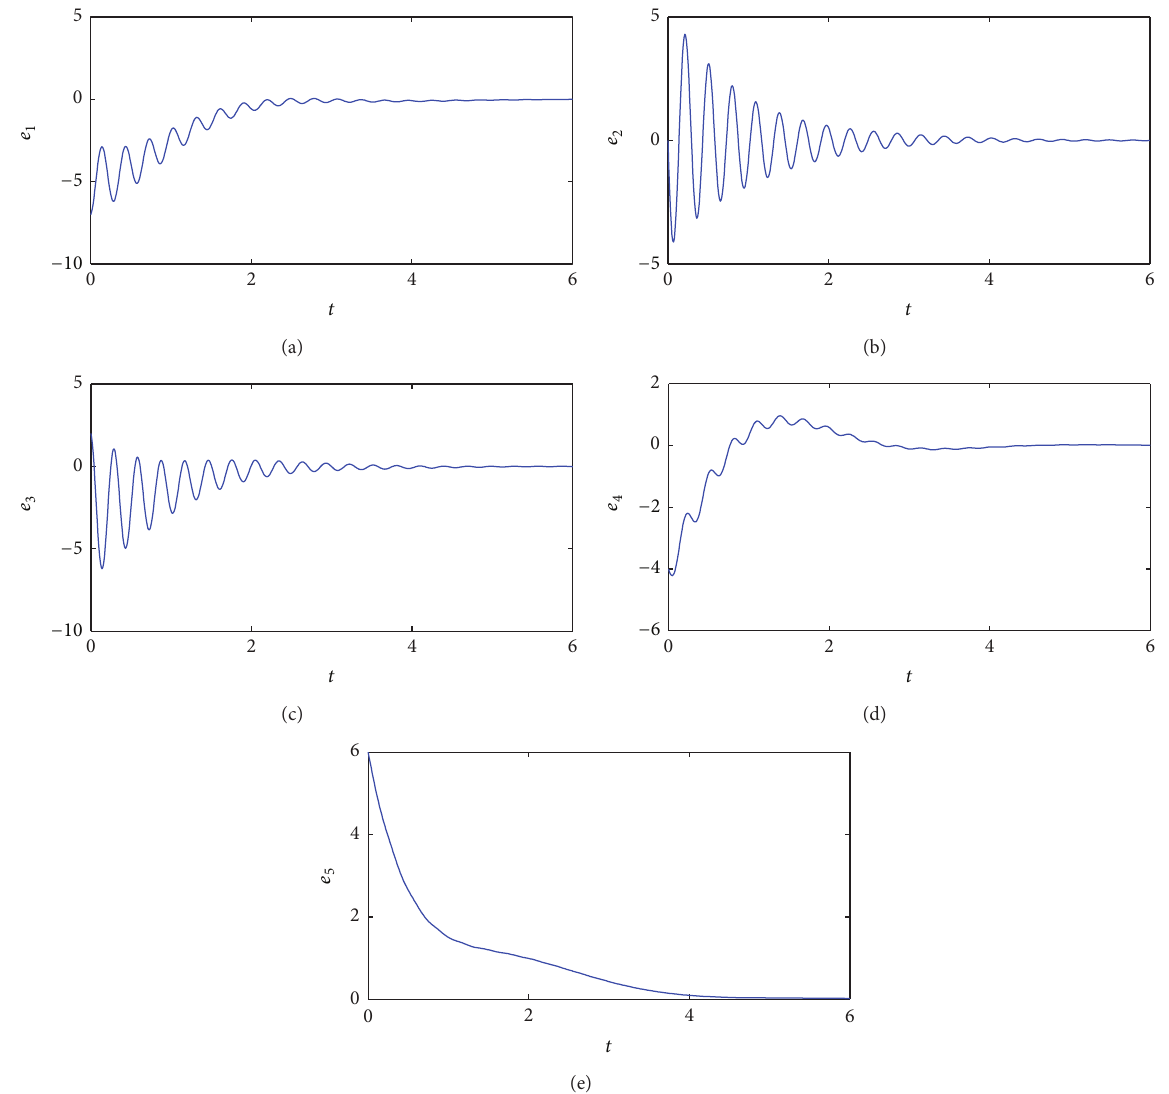
Figure 5: Combination-combination synchronization errors 𝑒 1 , 𝑒 2 , 𝑒 3 , 𝑒 4 , and 𝑒 5 between the drive systems (6) and (7) and the response systems (8) and (9), where 𝑒 𝑖 = 𝑢 𝑖 + V 𝑖 − 𝑤 𝑖 − 𝜇 𝑖 ( 𝑖 = 1,2, 3, 4, 5 ).